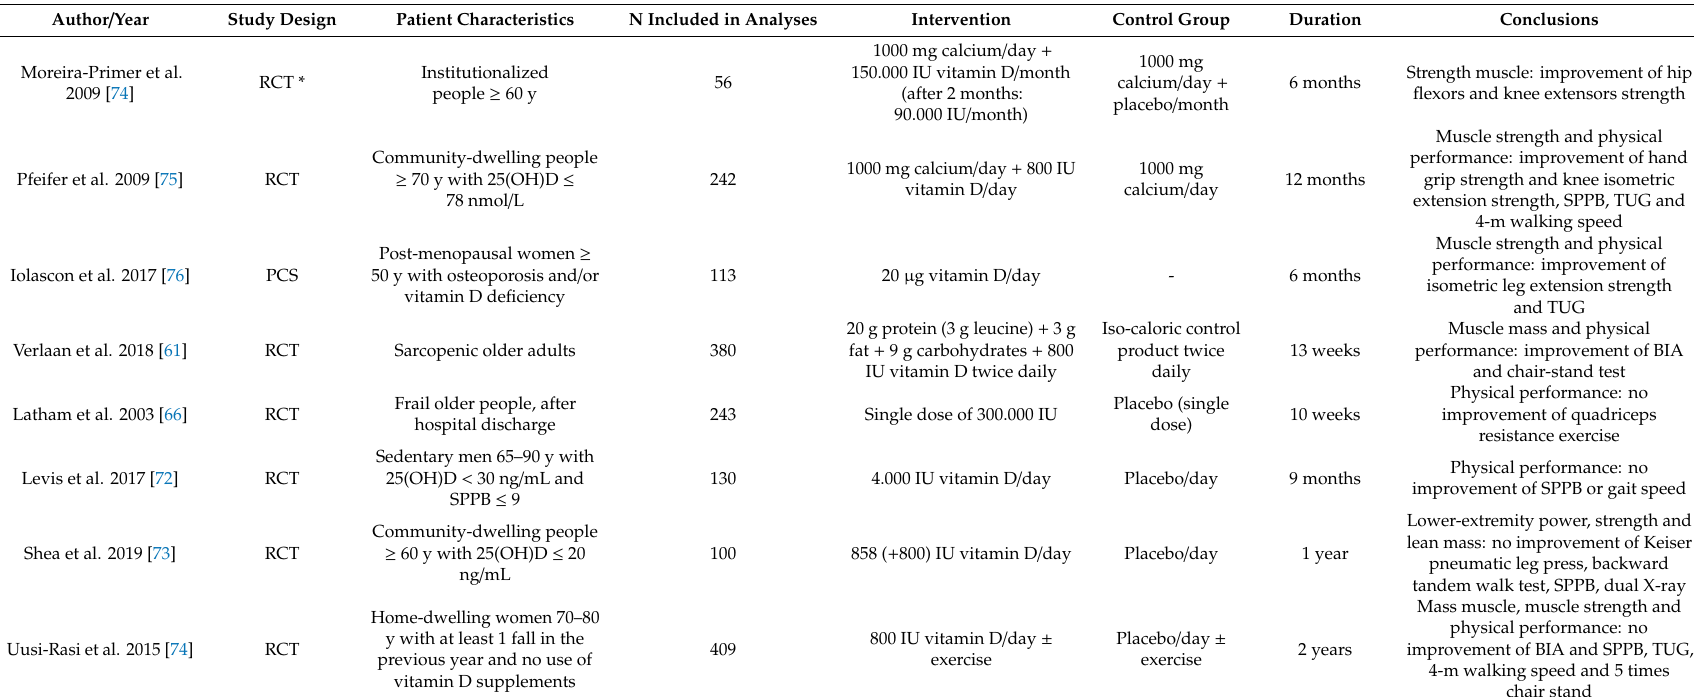
Table 1. Studies about Sarcopenia and oral vitamin D supplementation in older